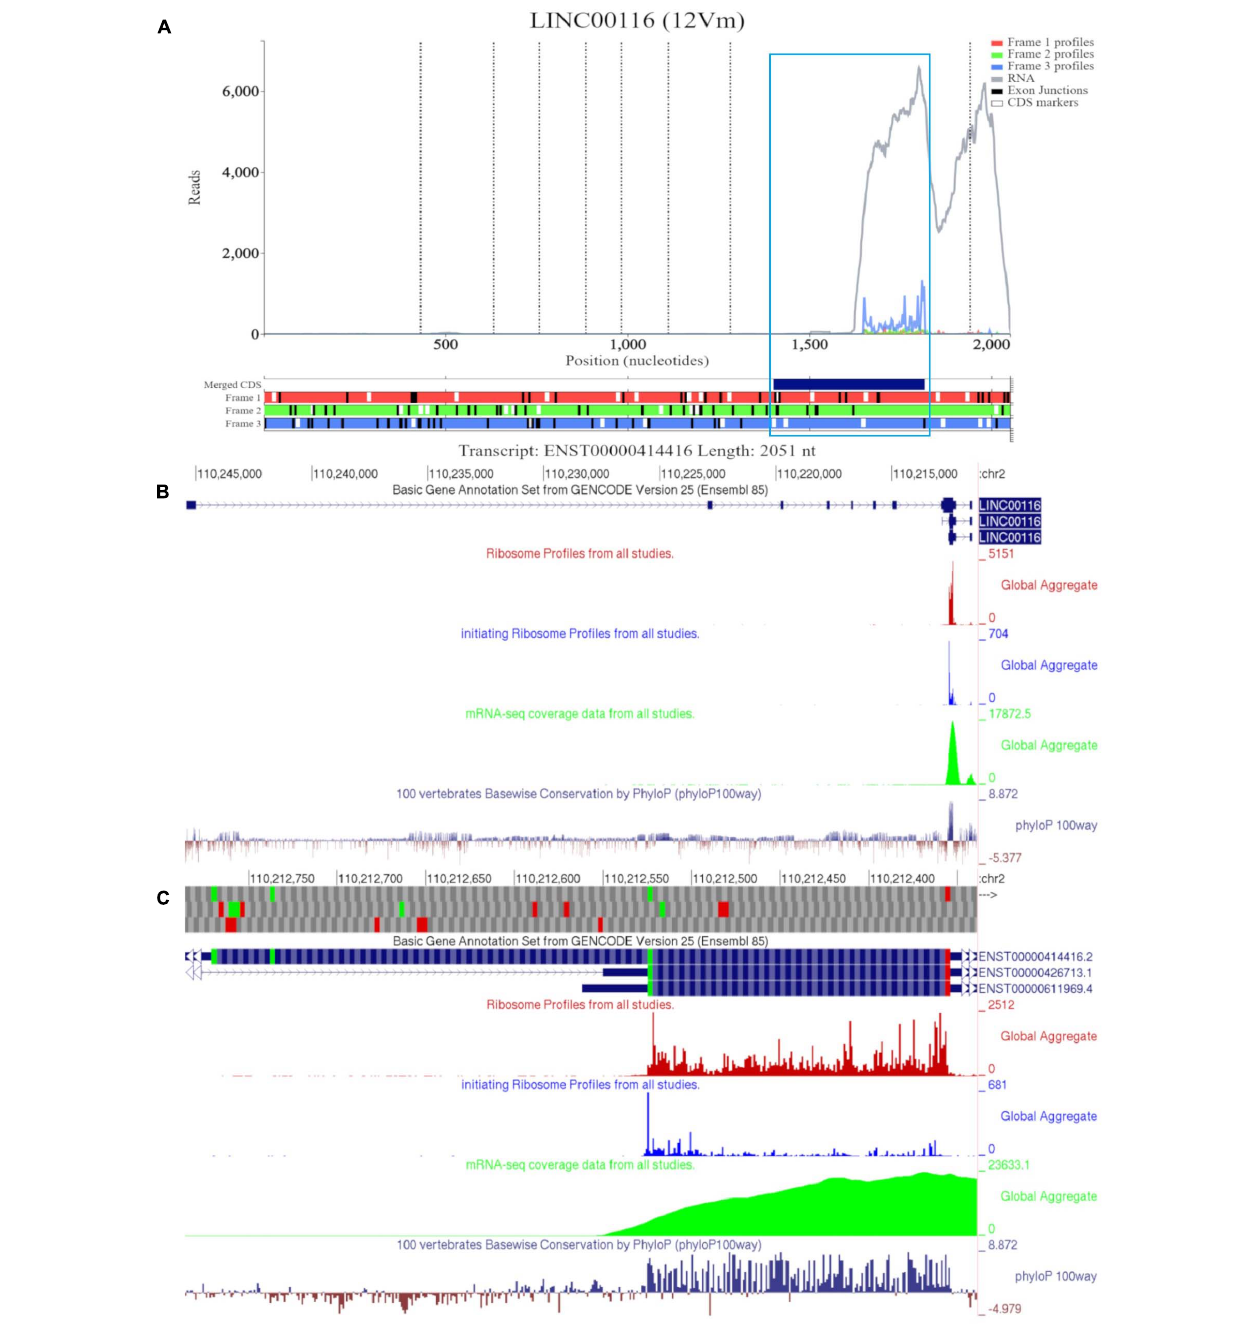
FIGURE 1 | Visualization of MTLN/LINC00116 in Trips-Viz and GWIPS-Viz. (A) Whole transcript view of MTLN in Trips-Viz with data indicating the protein product is shorter than the annotated coding sequence. (B) Visualization of MTLN/LINC00116 in GWIPS-Viz with the ‘Basic Gene Annotation Set from Gencode Version 25,’ ‘Ribosome Profiles from all studies,’ ‘initiating Ribosome Profiles from all studies,’ ‘mRNA-seq coverage data from all studies’ and ‘100 vertebrates Basewise Conservation by PhyloP100way’ tracks enabled. (C) Coding sequence on MTLN in GWIPS-viz with the tracks described in Setup and Configurations enabled.